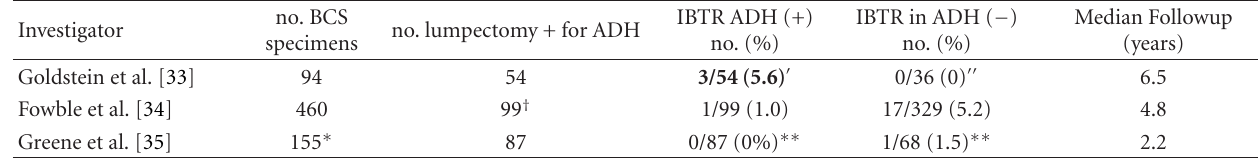
Table 2: Atypical ductal hyperplasia (ADH) and ipsilateral breast tumor recurrence (IBTR). no. Investigator